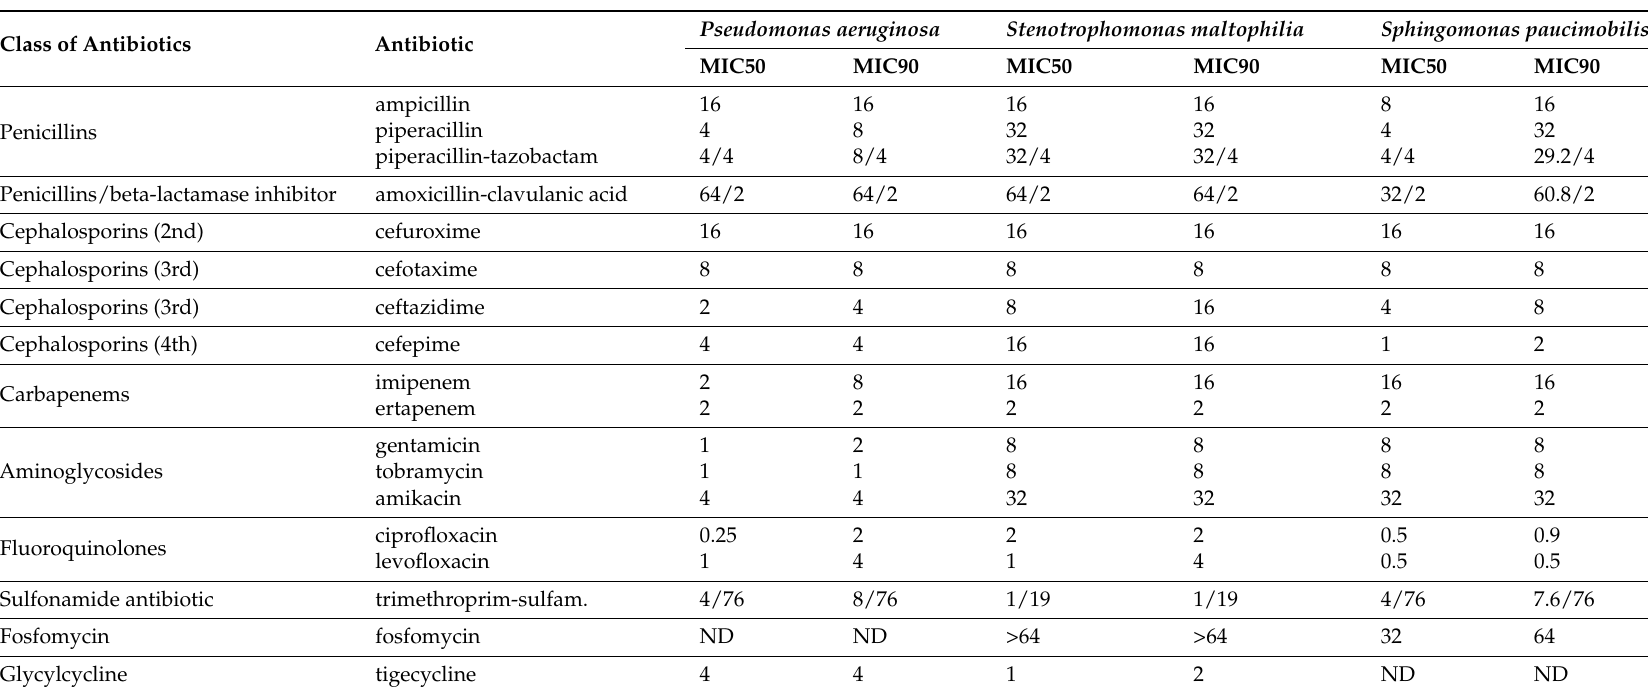
Table 7. MIC50 and MIC90 values of Pseudomonas aeruginosa , Stenotrophomonas maltophilia , and Sphingomonas paucimobilis isolates from water and surface areas. Class of